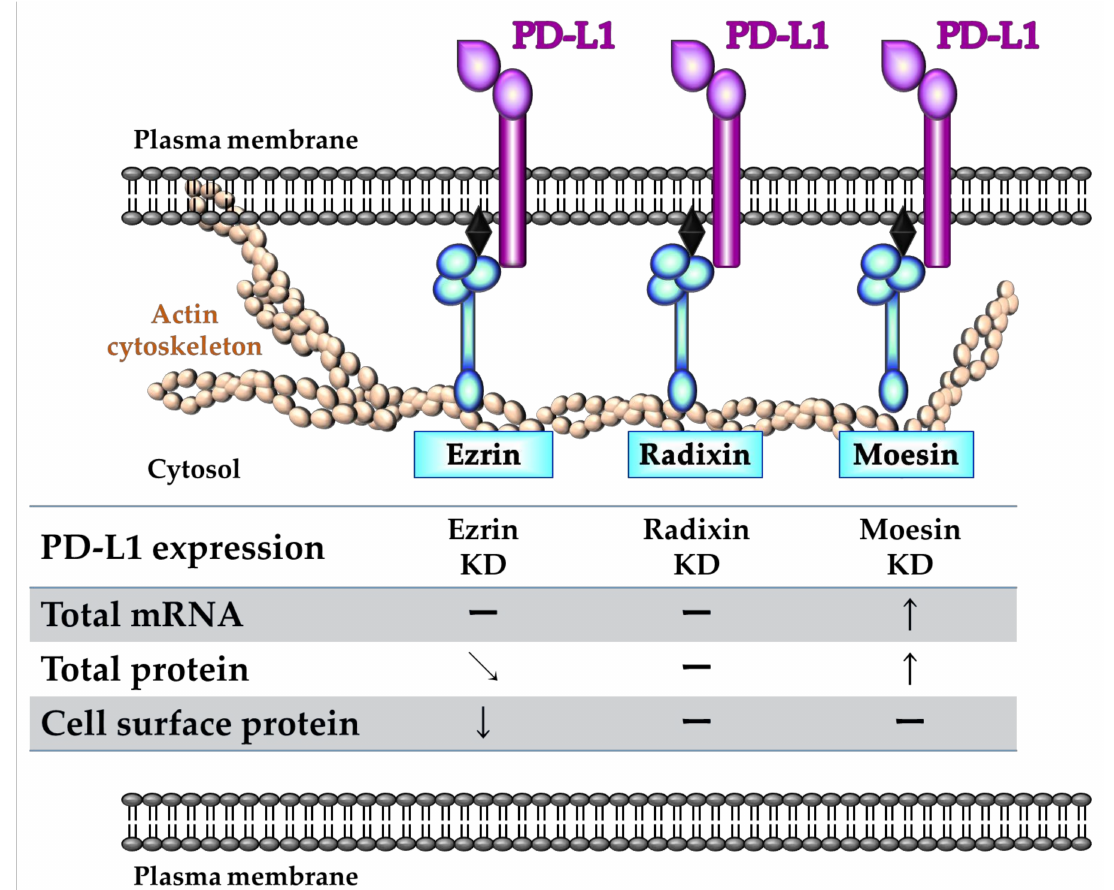
Figure 8. A proposed model illustrating the role of each ezrin/radixin/moesin (ERM) protein in the regulatory mechanism of programmed cell death ligand-1 (PD-L1) expression in HeLa cells. Ezrin regulates the plasma membrane localization of PD-L1 possibly via the protein–protein interaction, with little influences on its mRNA and total protein levels. Despite the existence of the protein–protein interaction with PD-L1, radixin and moesin might not contribute to the plasma membrane localization of PD-L1. In addition, moesin may negatively regulate PD-L1 expression at the mRNA and total protein. Therefore, among ERM proteins, ezrin plays a key role in crosslinking PD-L1 with actin cytoskeleton, resulting in a stabilization of PD-L1 in the plasma membrane of HeLa